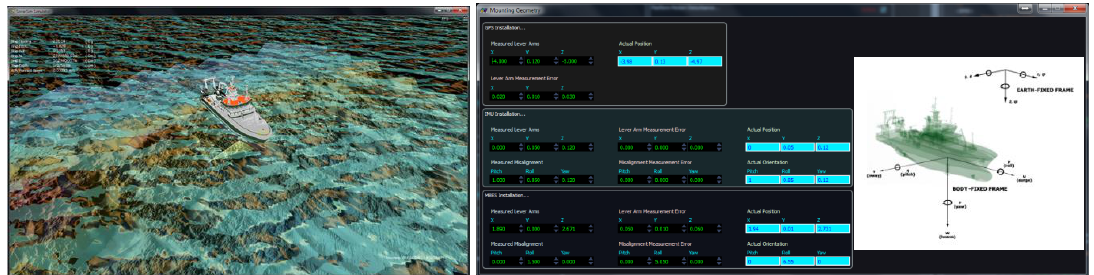
Figure 7. ( Left ) 3D transparent ocean viewer and ( right ) sensor mounting configuration GUI.